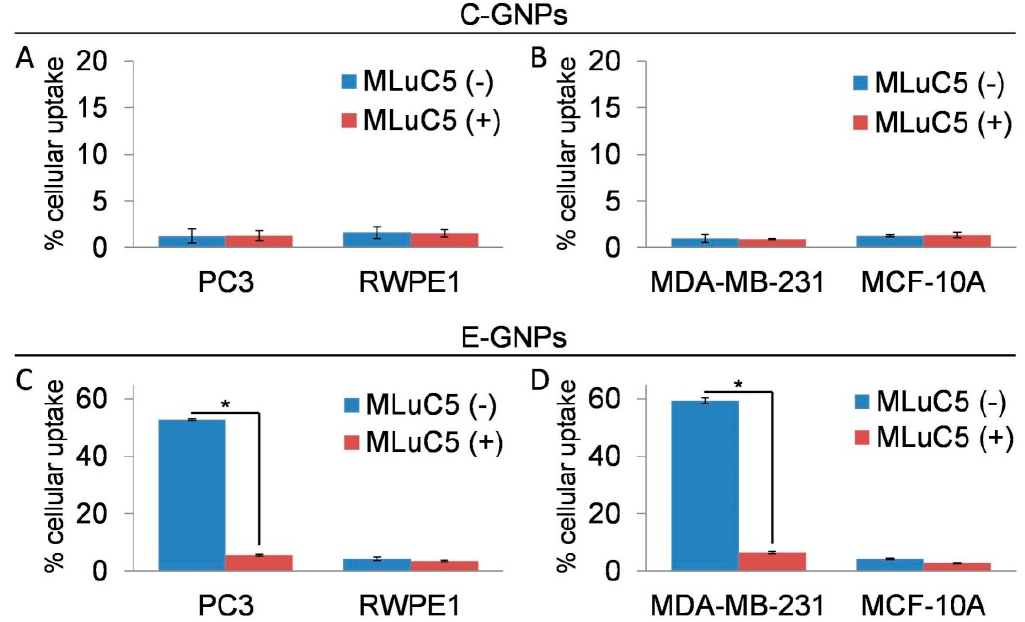
Figure 4. Laminin receptor blocking significantly reduces uptake of E-GNPs by cancer cells. Atomic absorption spectroscopy (AAS) analysis data from PC3 and RWPE1 cells showing the effect of laminin receptor blocking by MLuC5 antibody on cellular uptake of C-GNPs ( A ) and E-GNPs ( C ). AAS analysis data from MDA-MB-231 and MCF-10A cells showing the effect of laminin receptor blocking by MLuC5 antibody on cellular uptake of C-GNPs ( B ) and E-GNPs ( D ). Bars represent the mean of triplicates ± SD, * p ˂ 0.05.